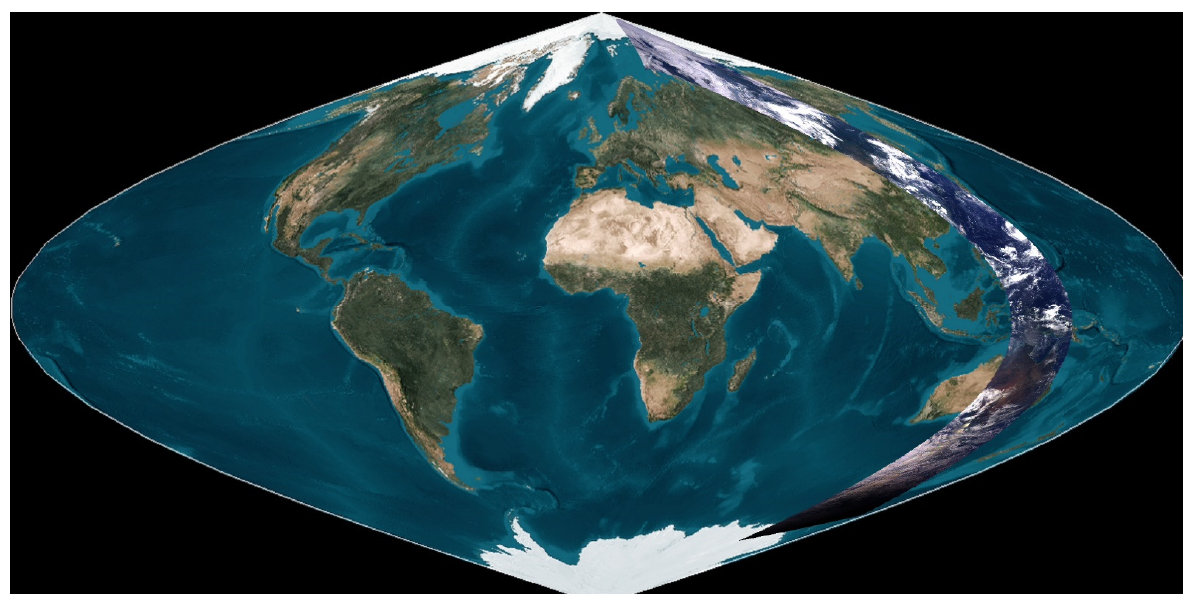
Figure 2. DPC overview imagery on 21 March 2017. The size of the whole image is 12,168 × 6484. The striped zone on the right is the valid observation area, and the rest is the invalid filled zone. This striped image is obtained by pseudo-color synthesis of the reflectance image of the third angle of 670 nm band, 565 nm band, and 490 nm band.